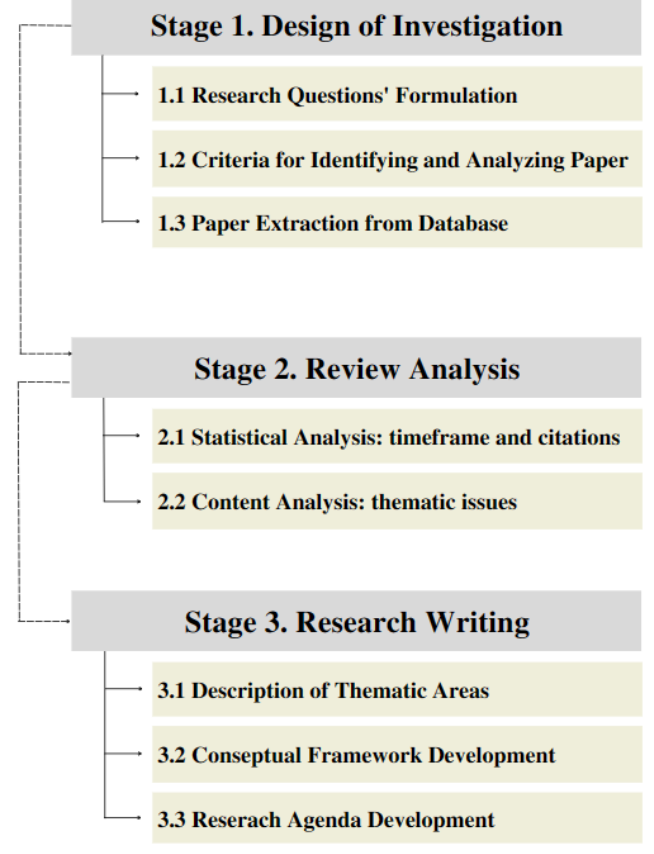
Fig. 1 The Research Stages of the Critical Literature